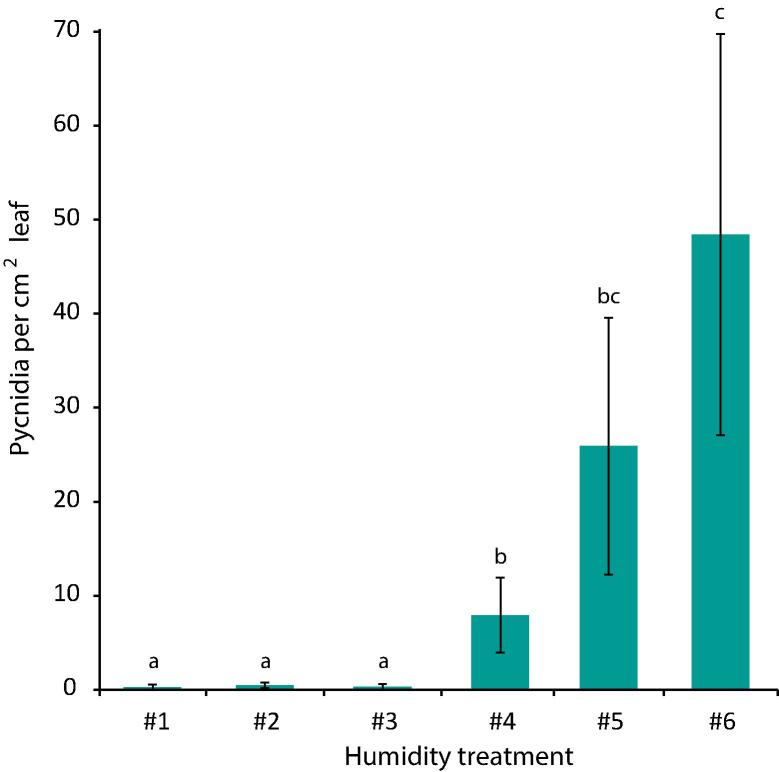
Effect of humidity pycnidiation by Z. tritici IPO323. Galaxie wheat plants were inoculated with 106 cfu/ml suspensions of Z. tritici and maintained under six different humidity regimes (#1 – lowest to #6 – highest). Inoculated leaves were examined at 21 dpi and pycnidia enumerated. Data are means of three independent experiments; error bars show SE. Different letters indicate significant differences between results (ANOVAs with Tukey’s simultaneous comparisons).